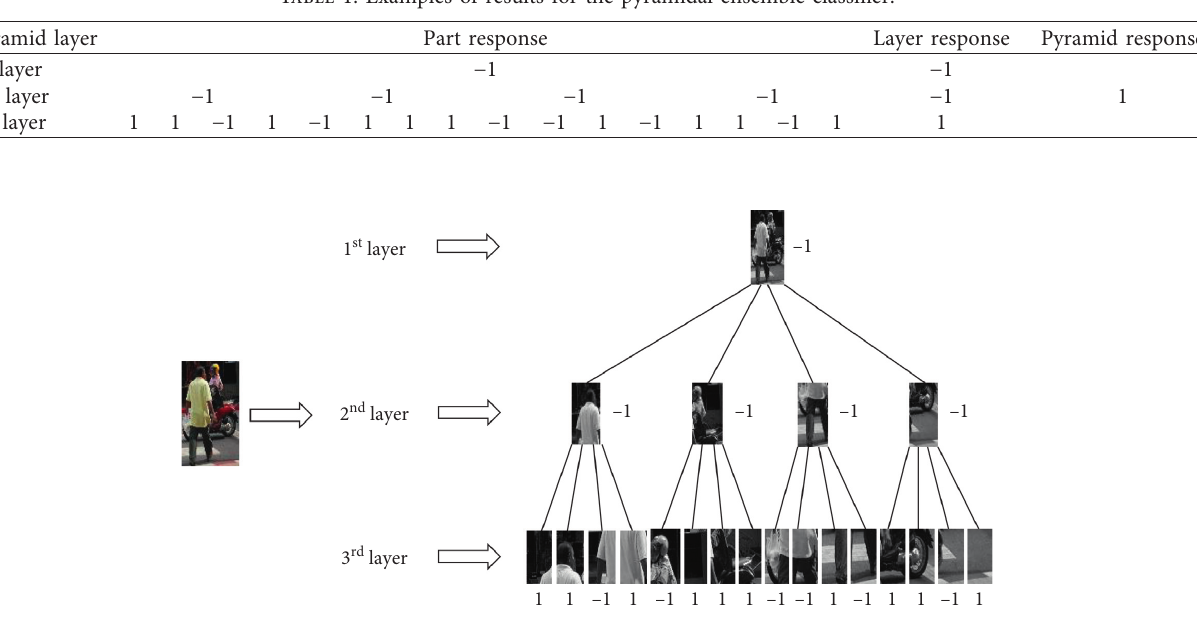
Figure 6: Illustration of the part representation process using the pyramidal ensemble